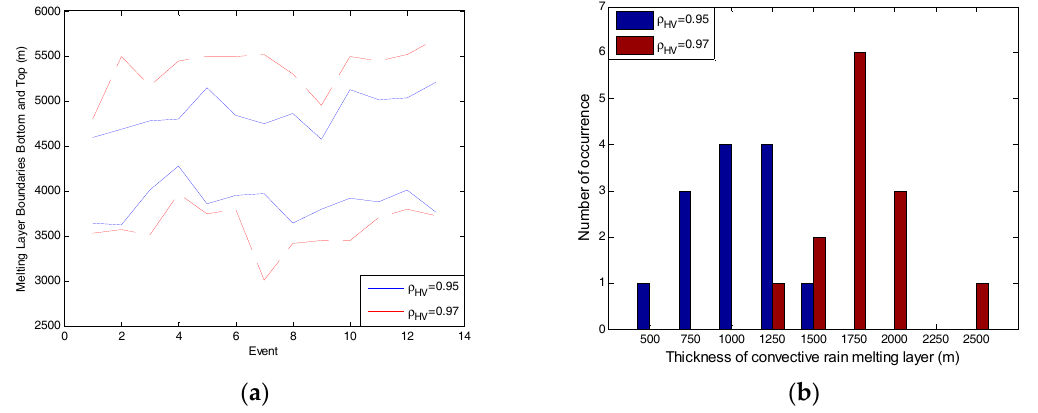
Figure 9. ( a ) Melting layer bottom and top heights of convective rain cell ( b ) Histogram of convective rain cell melting layer thickness using two different thresholds.